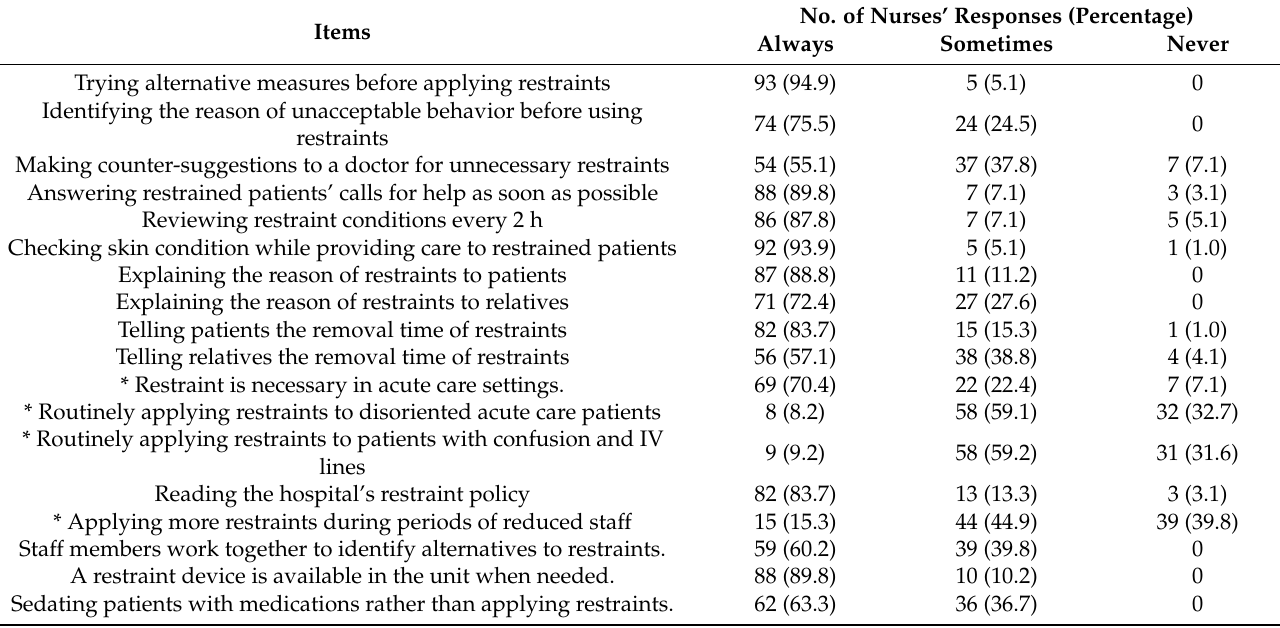
Table 4. Nursing practice issues regarding physical restraints ( n = 98).